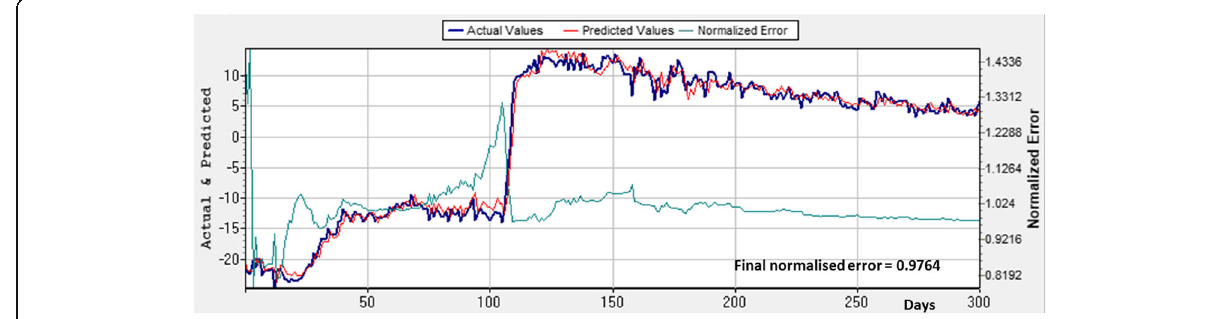
Fig. 17 Nonlinear prediction of CNST_e signal. The blue curve is the observed signal, the red is predicted and the green curve is the normalised error which is less that one and so marginally better than a linear prediction model given by (7). The prediction lags behind the observed signal by 1 day so is not ideal for practical predictive purposes but is a good test of the data